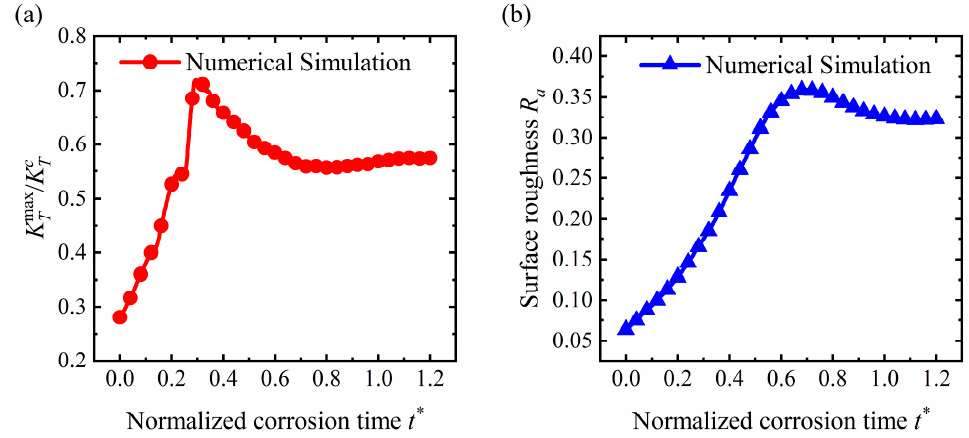
Figure 11. ( a ) Surface morphology evolution process and ( b ) corrosion rate distribution when σ = . * 0.1 A = 50MPa A